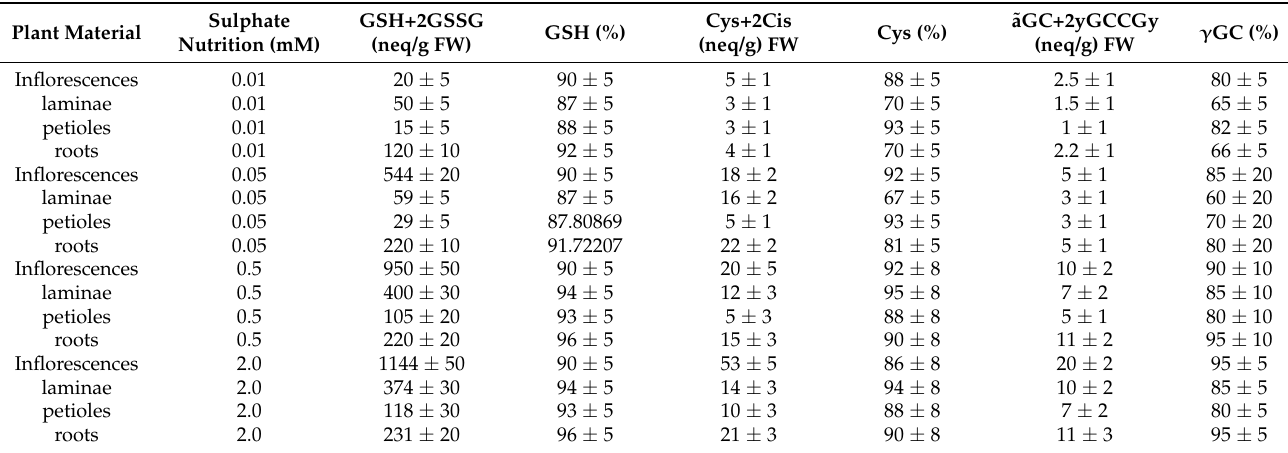
Table 3. Total glutathione (GSH+2GSSG), total cysteine and total y-glutamilcisteine in nanoequivalents per gram of fresh weight (neq/g FW), as well as the percentage of the reduced forms in inflorescences, laminae, petioles and roots of Brassica rapa L. cv Sylvestris plants grown in nutrient solutions containing 0.01, 0.05, 0.5 and 2 mM sulphate. Plant